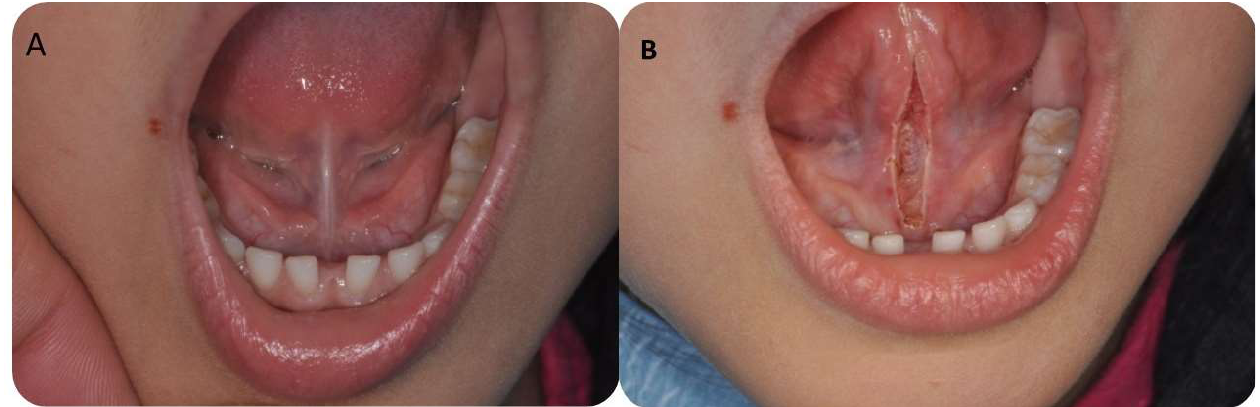
Figure 1. ( A ) Clinical aspect before atmospheric plasma treatment. ( B ) After atmospheric plasma treatment.